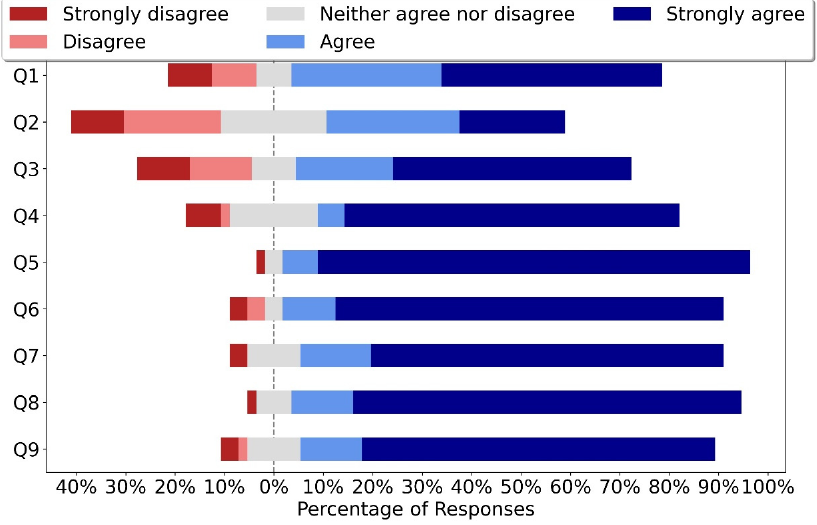
Figure 7. Likert-scale question analysis of H5P features.